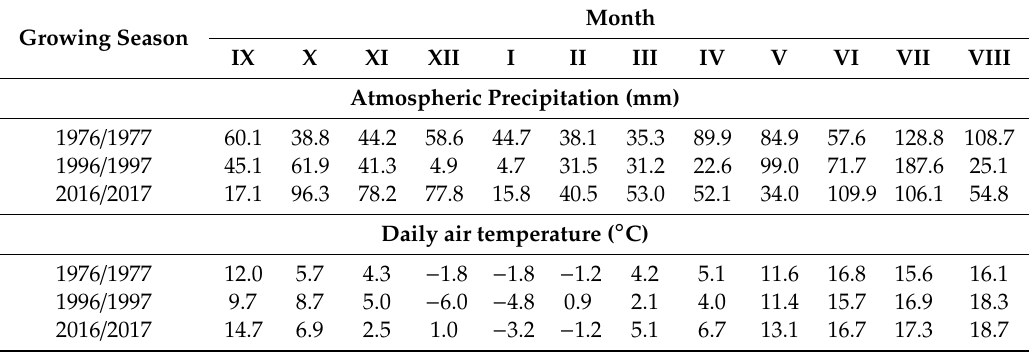
Table 1. Atmospheric precipitation and daily air temperature during the study periods according to the Meteorological Station in